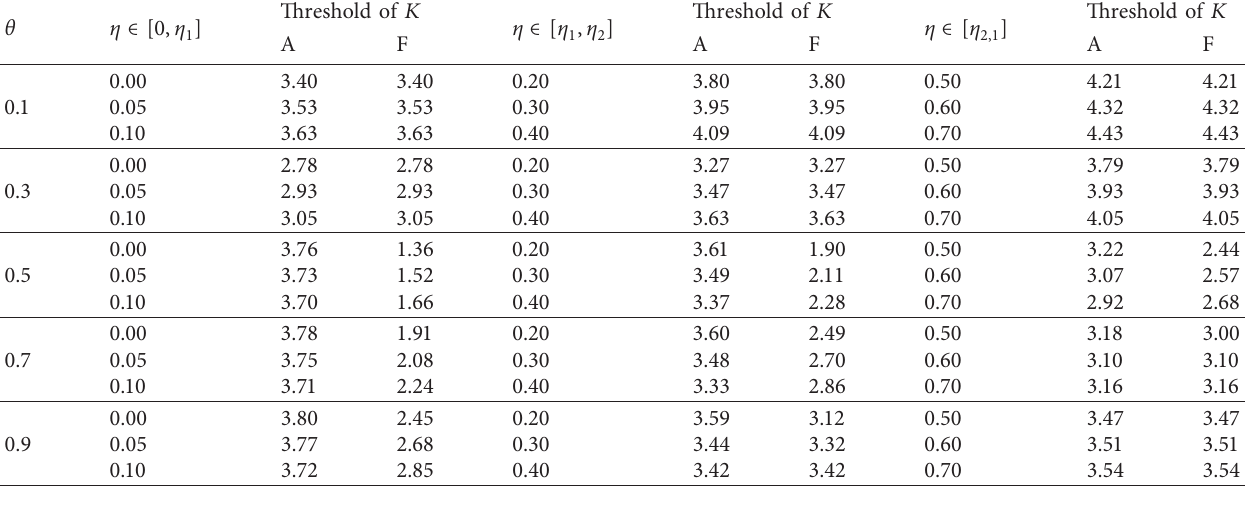
Table 5: The impact of θ and η on K under different channel strategies.